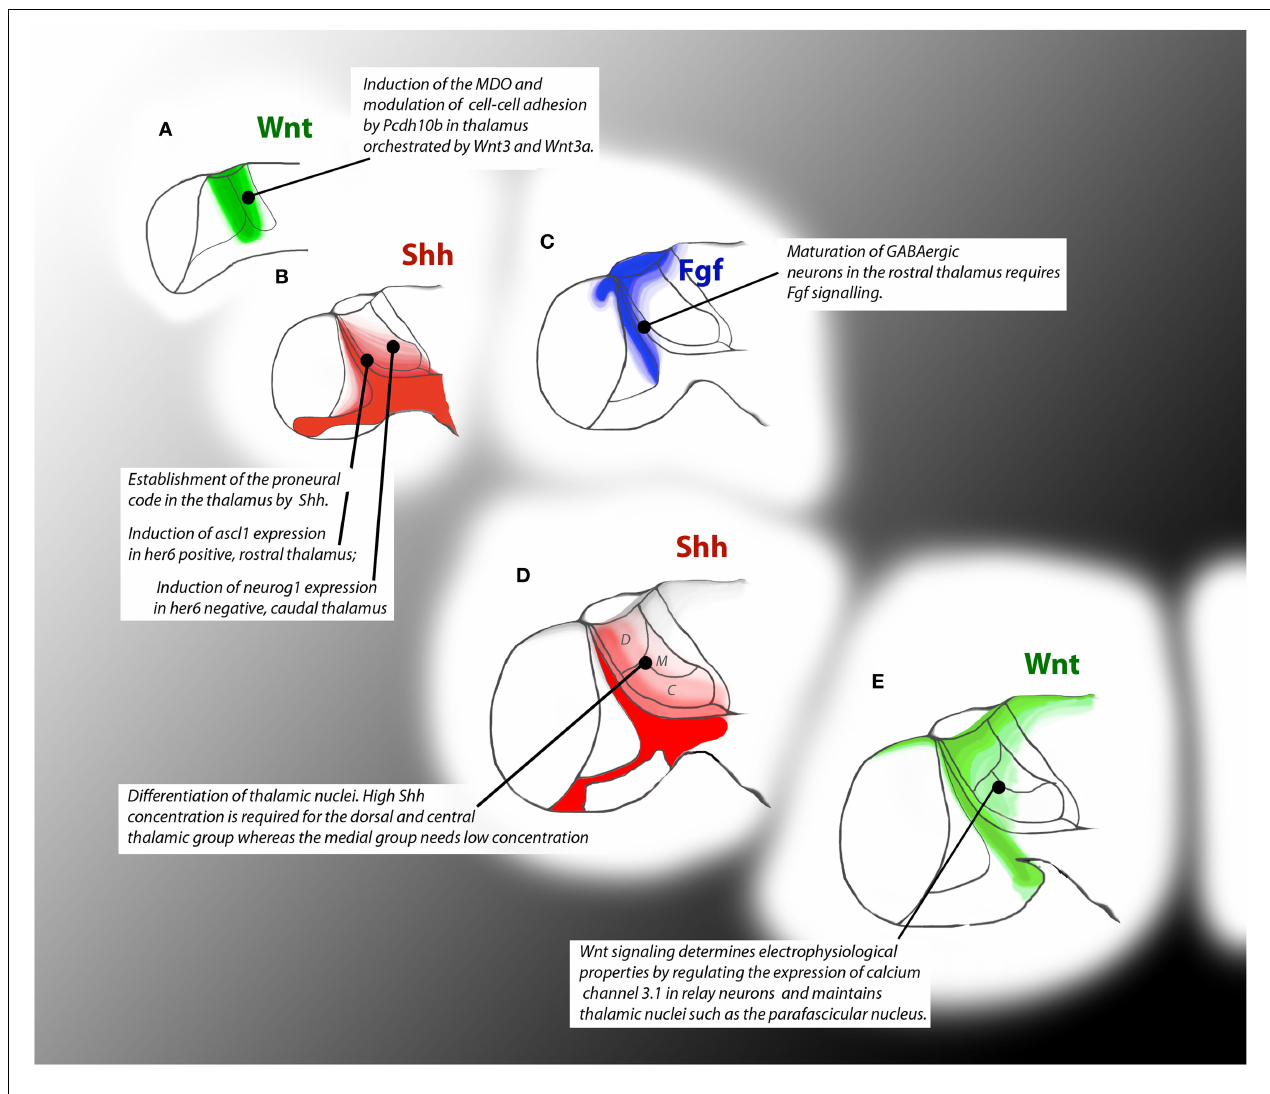
neurogenesis by induction of proneural genes (B) whereas Fgf signaling influences maturation of GABAergic neurons (C) . At 36hpf, graded Shh signal specifies the territory of the thalamic nuclei (D) . At48hpf,Wnt signaling guides neurogenesis by influencing post-mitotic characteristics of thalamic neurons (E)